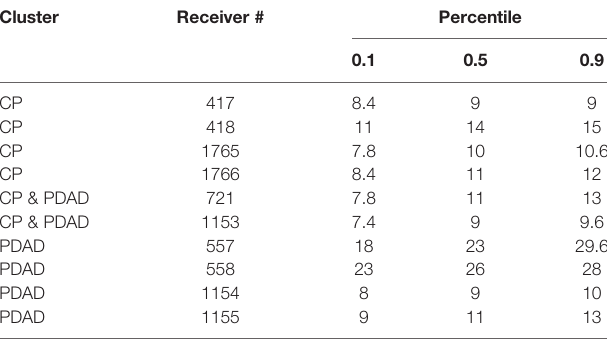
TABLE 5 | 10 Minutes average noise measured by the